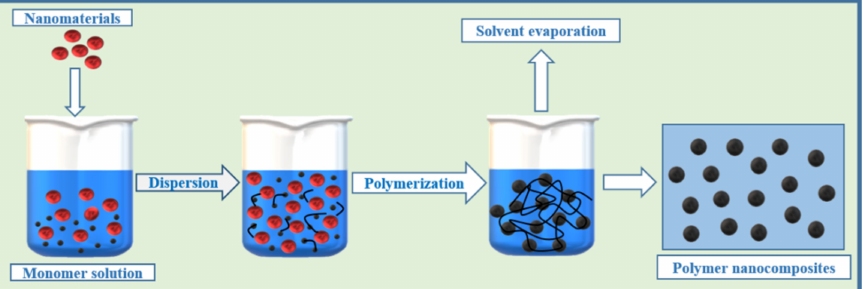
Figure 2. Schematic illustration of the in situ polymerization